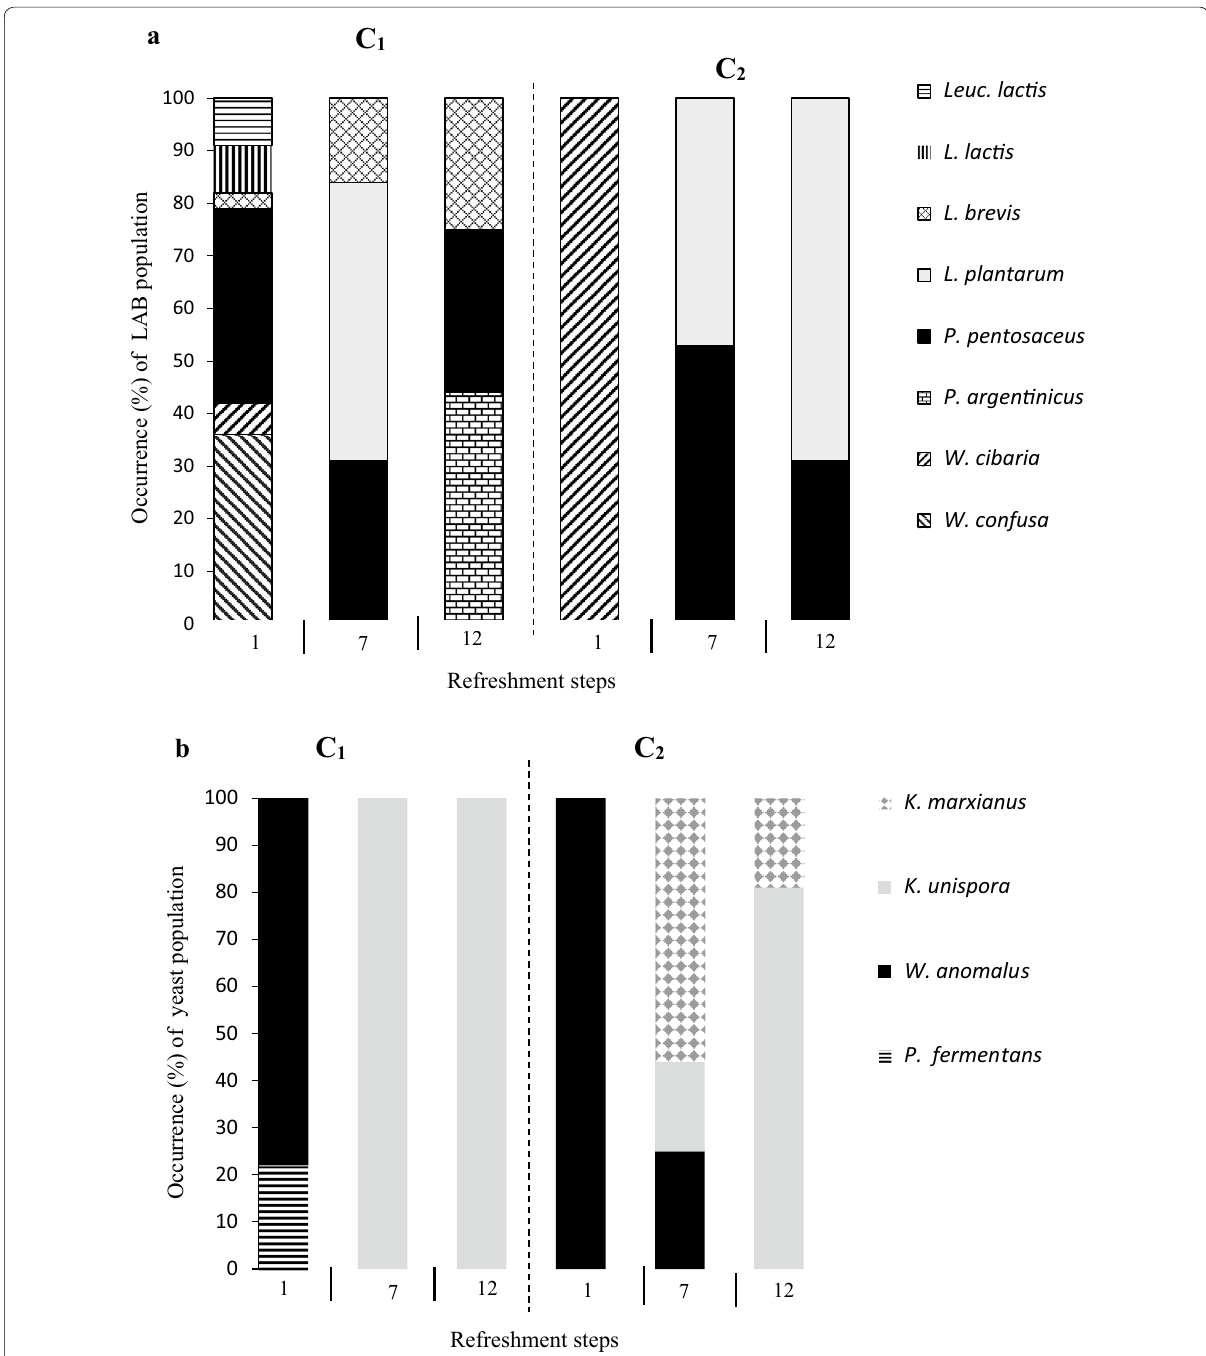
Fig. 3 Changes in community structure of lactic acid bacteria ( a ) and yeasts ( b ) during sourdough-like fermentation of the two maize bran samples (C1 and